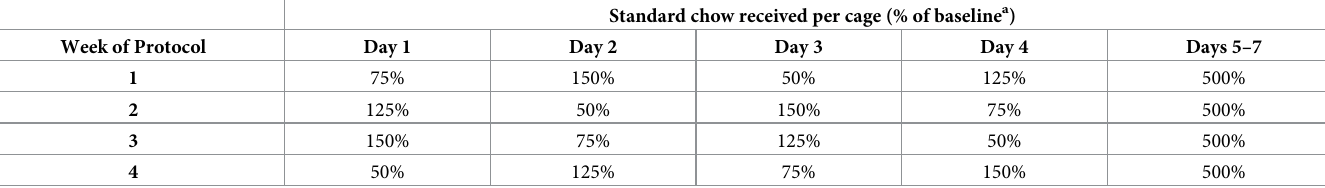
Table 1. Food insecurity protocol timeline.